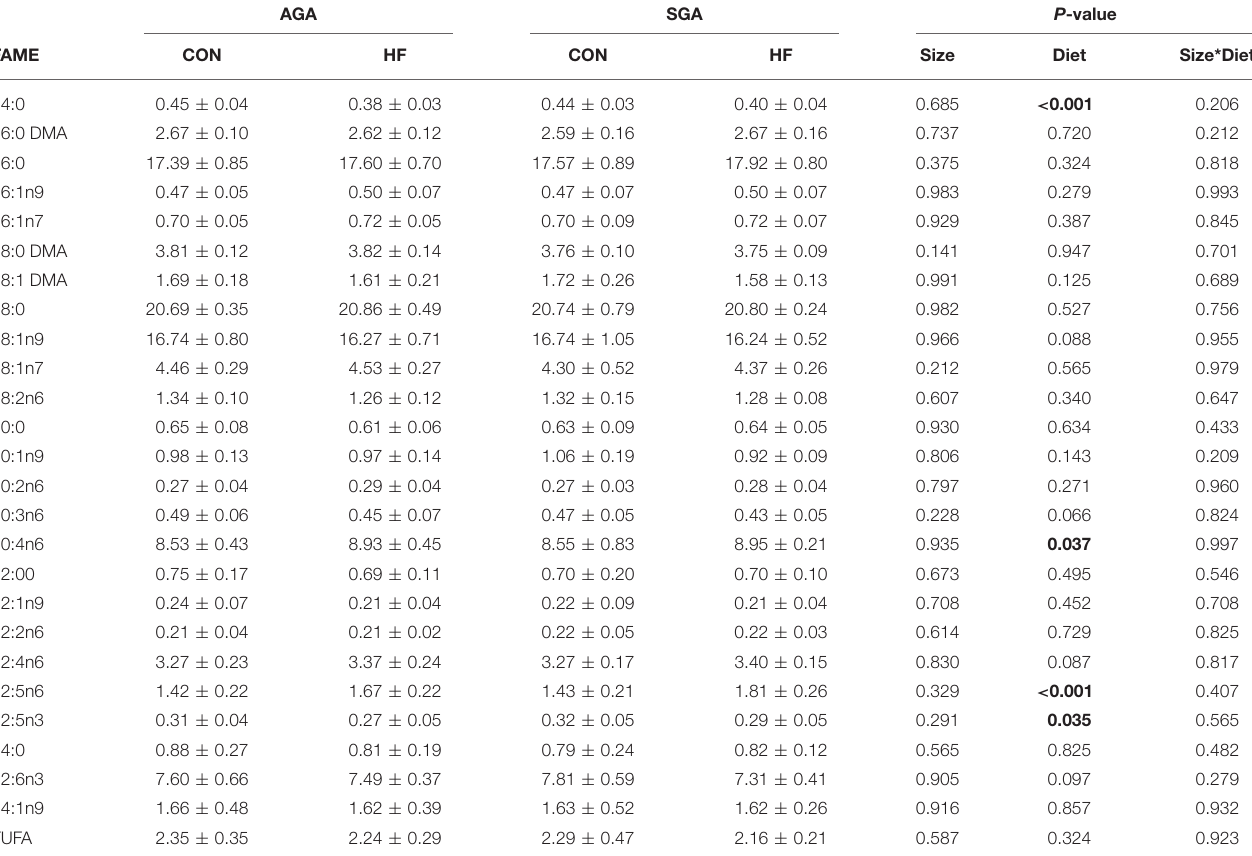
a Values presented as the means ± SEM of percent of total fatty acids of 8–9 replicate pigs collected at 26–29 days of age. AGA CON n = 8, AGA HF n = 8, SGA CON n = 9, SGA HF n = 9. Bold values are